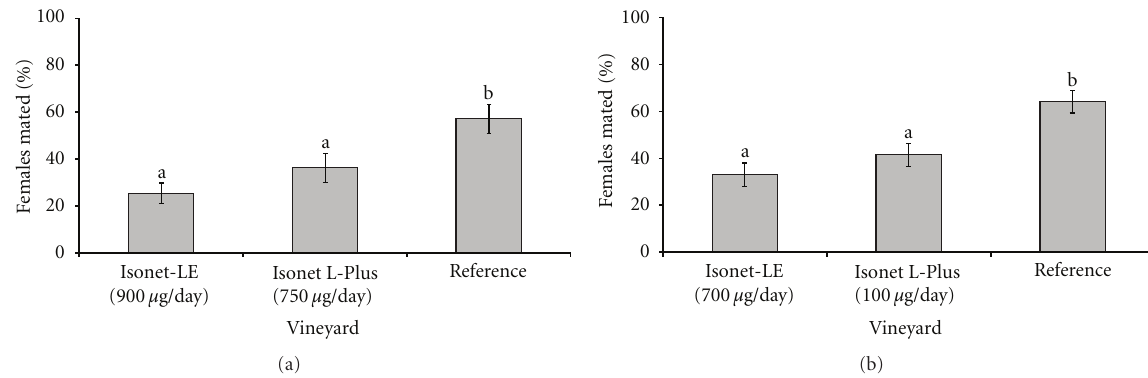
Figure 2: Percentage of mated (a) L. botrana and (b) E. ambiguella females in field cages (mesh size = 1500 µ m) containing no pheromone dispenser. The notation µ g/day represents approximately the daily emission rate of pheromone dispensers for (a) L. botrana and (b) E. ambiguella . Pest control schemes with di ff erent letters are significantly di ff erent ( P < 0 . 01); data are untransformed; bars = 1 SE.